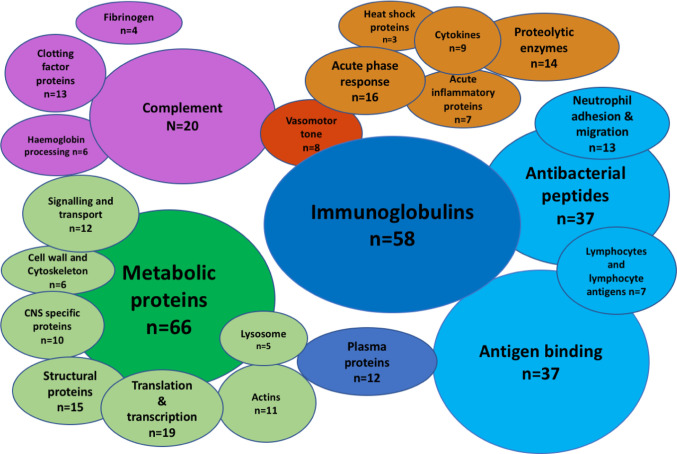
The CSF proteome in pneumococcal meningitis is diverse and highly inflammatory. Bubble plot summary of the CSF proteome in pneumococcal meningitis. Three hundred thirty-six peptides identified by Mass-Spectrometry. Green, cellular functional proteins; blue, proteins synthesized by white and plasma cells; purple, complement and clotting cascades; orange, pro-inflammatory proteins.